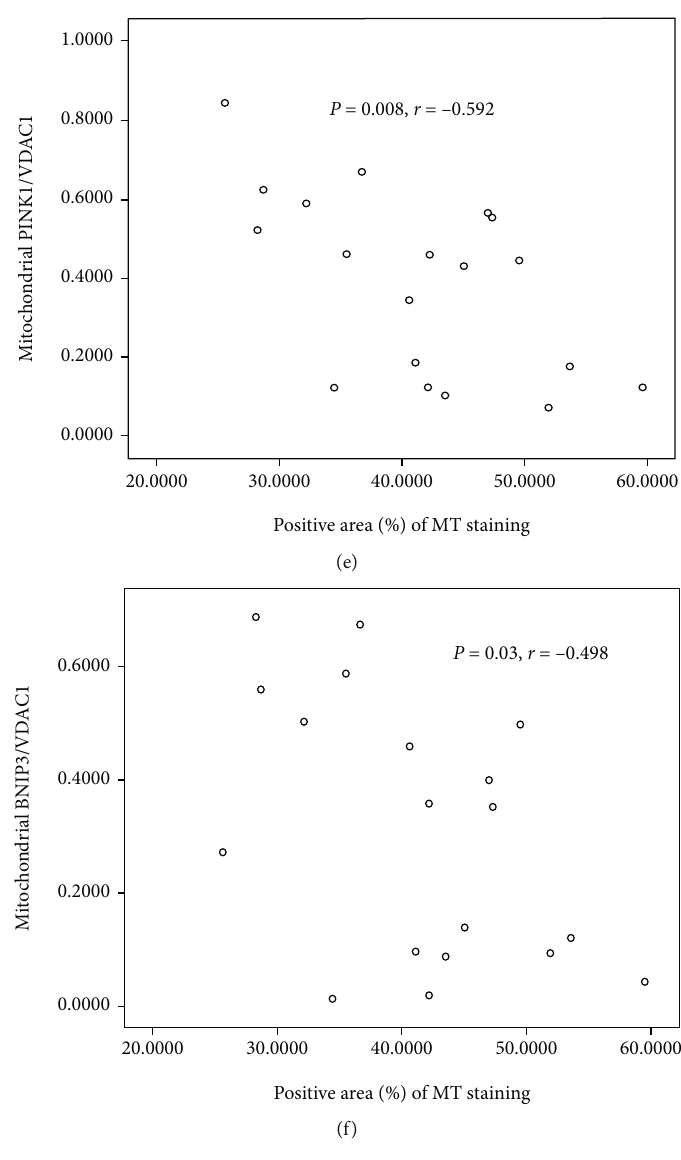
Figure 6: Tissue remodeling in di ff erent CRSwNP subtypes. (a, b) PAS – AB stain covered a greater area in sections of the nasal polyps of patients with eCRSwNP or noeCRSwNP, compared with control tissues. (c, d) MT stain covered a greater area in tissue sections from patients with eCRSwNP or noeCRSwNP, compared with control tissues. (e, f) Mitochondrial PINK1 and BNIP3 levels were signi fi cantly inversely correlated with the results of MT staining in patients with noeCRSwNP. ∗ P < 0 : 05 , ∗∗ P < 0 : 001